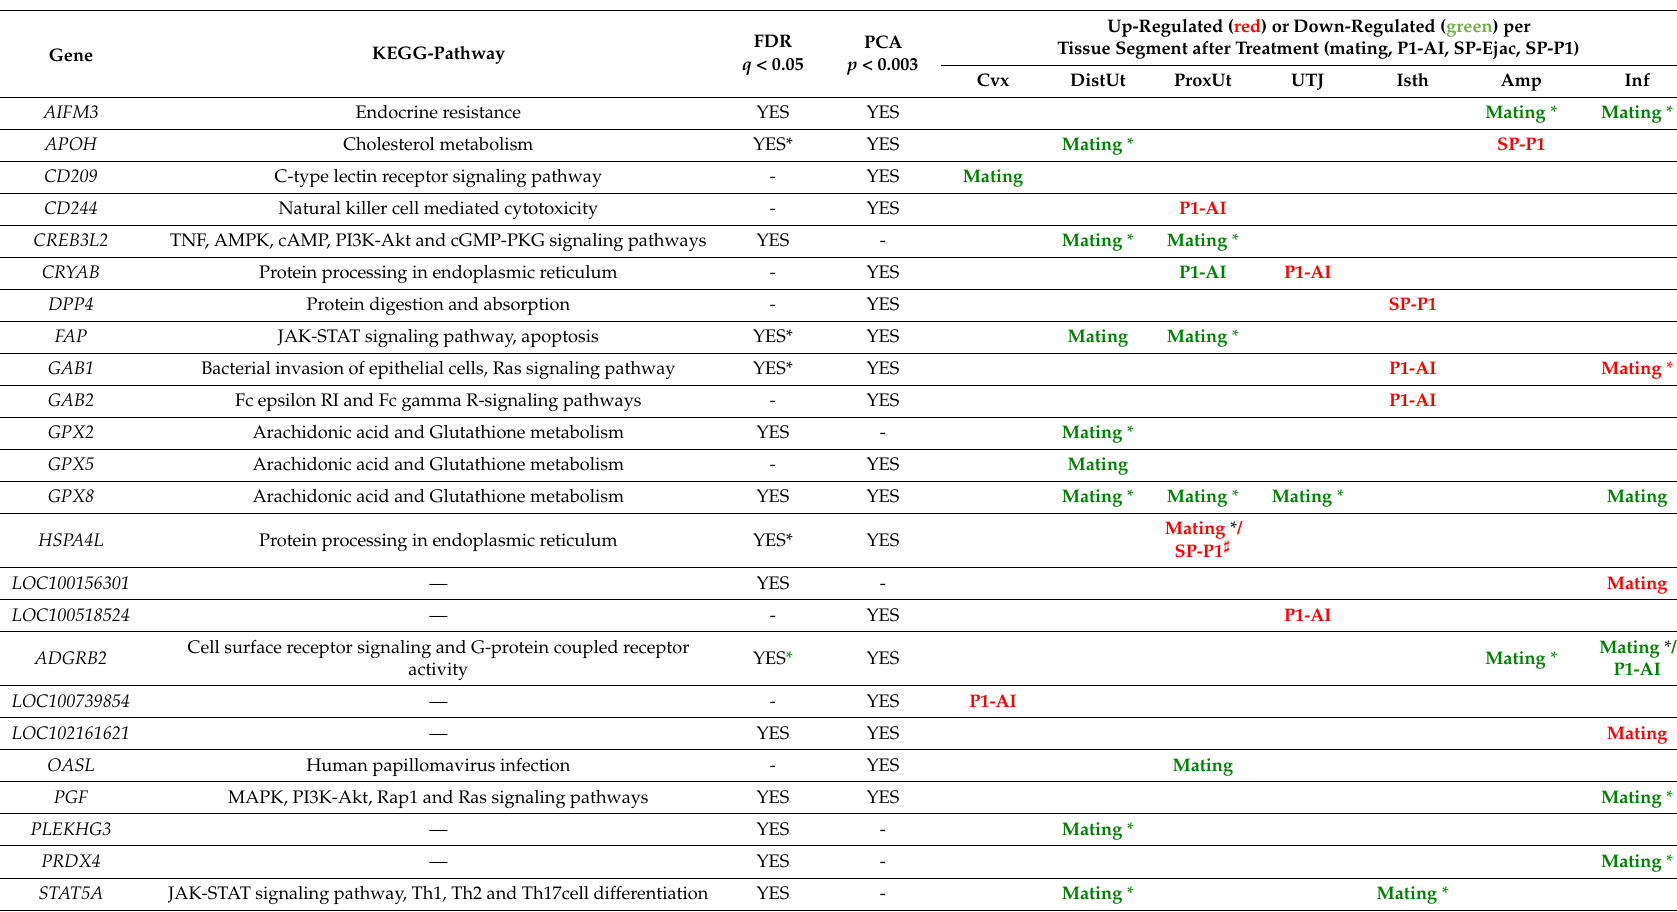
Table 2. Immune-process genes (FDR/PCA, including Kyoto Encyclopedia of Genes and Genomes (KEGG) pathway/s) displaying changes in expression in specific segments (Cvx: cervix, DistUt: distal uterus, ProxUt: proximal uterus, UTJ: Utero-tubal junction, Isth: isthmus, Amp: ampulla or Inf: infundibulum) of the pig estrous internal genital tract, 24 h after mating or cervical deposition of the sperm-peak portion (P1-AI), of its SP (SP-P1) or SP from the whole ejaculate (SP-Ejac). Gene